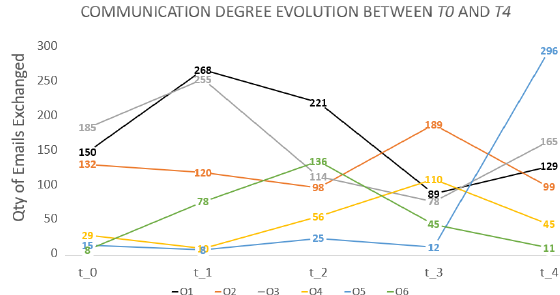
Figure 7. Communication degree evolution between t0 and t4 for project